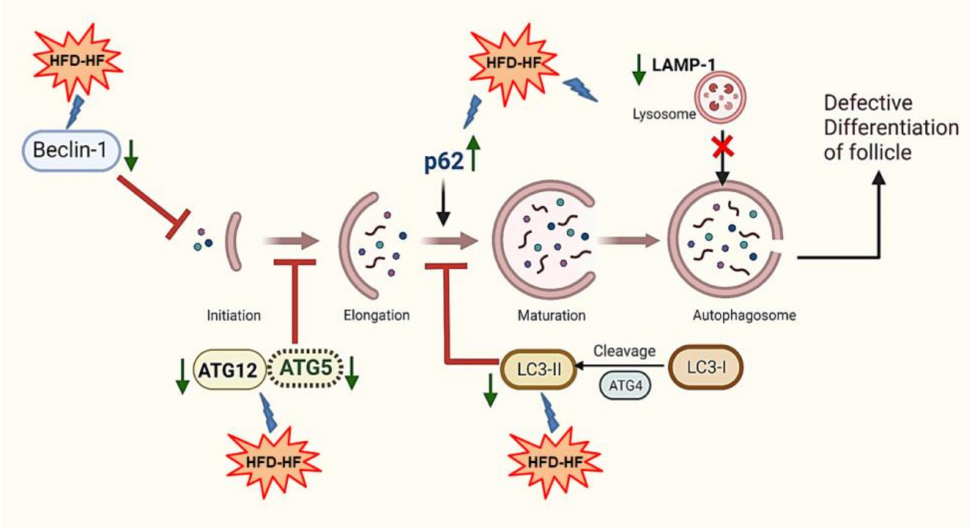
Scheme 3. Effects of the HFD-HF diet elicited the inhibition of autophagy, leading to the defective differentiation of ovarian